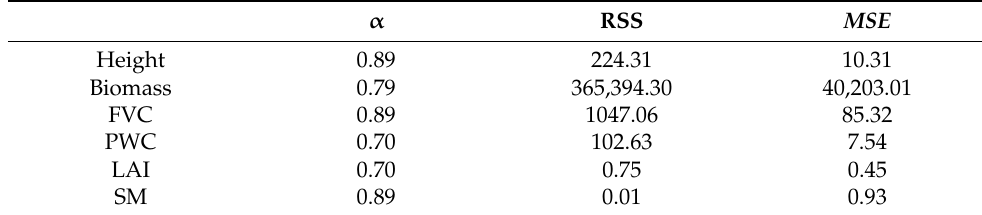
Table 5. Double smoothing results.